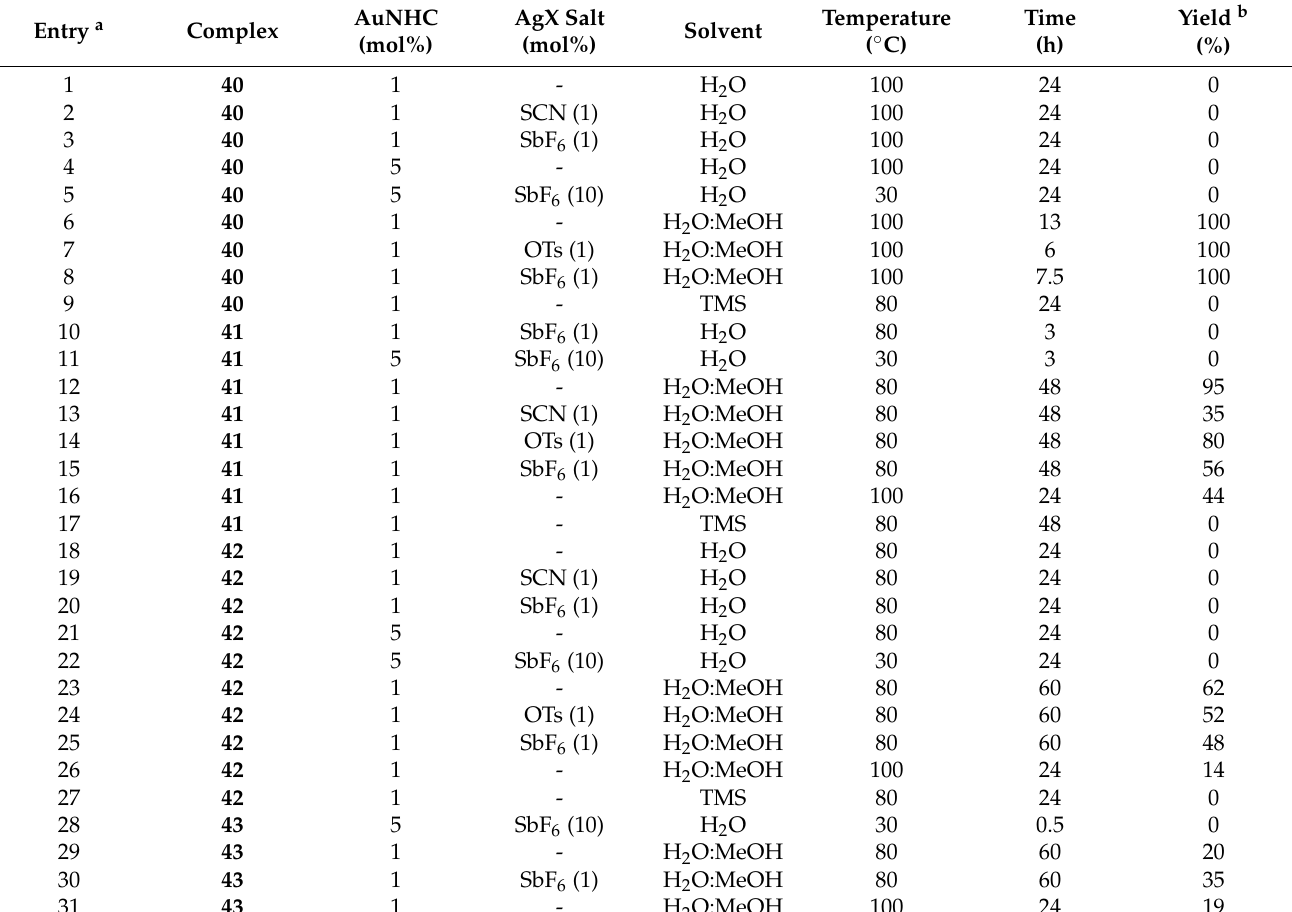
Table 16. Hydration of alkynes catalyzed by 40 – 43